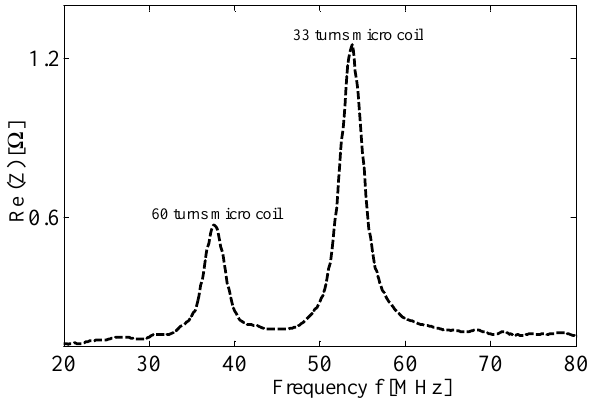
Figure 13. Simultaneously measured wireless resonance frequen- cies of two di ff erent micro coils with 33 and 60 turns using electri- cally small loop antenna.